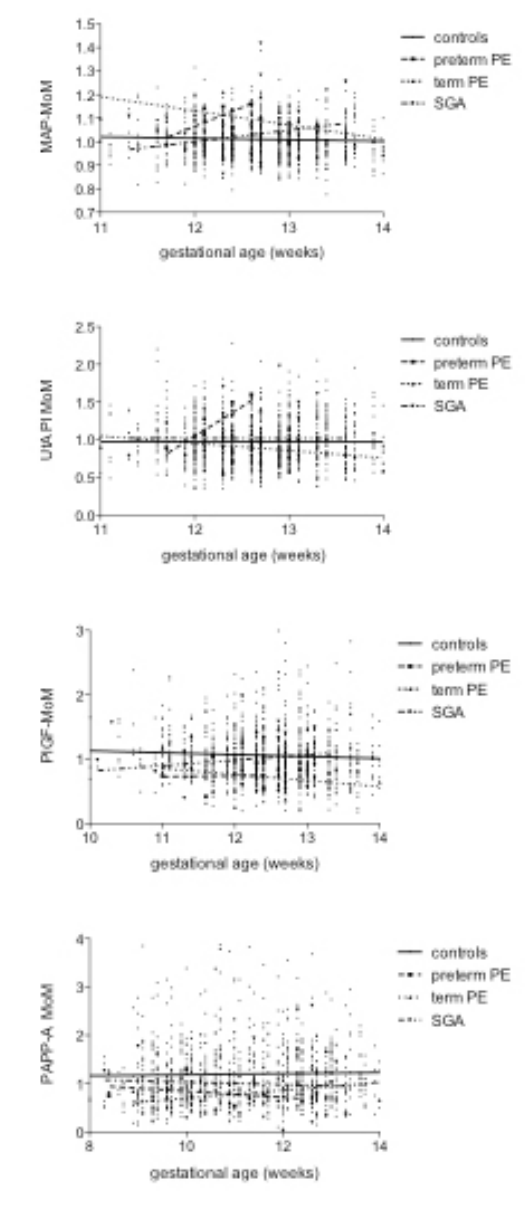
Figure 1: Mean arterial pressure, uterine artery Doppler, placental growth factor (PlGF) and pregnancy-associated plasma protein A (PAPP-A) and their multiple of the medians (MoMs) in uneventful and complicated pregnancies over the course of the first trimester.PE = preeclampsia; SGA = small for gestational